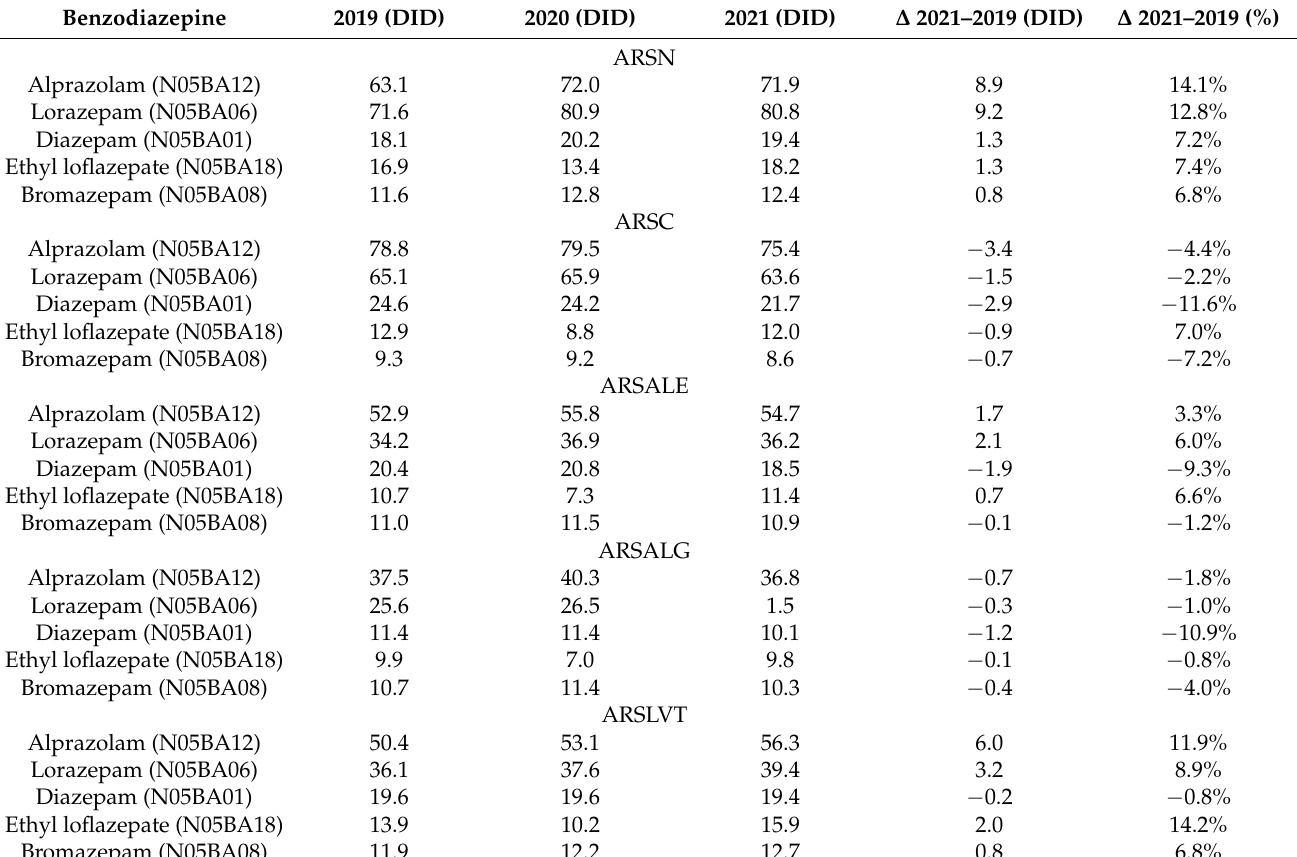
Table 2. DID change rate ( ∆ in %) of the top five benzodiazepines, in each ARS, stratified by